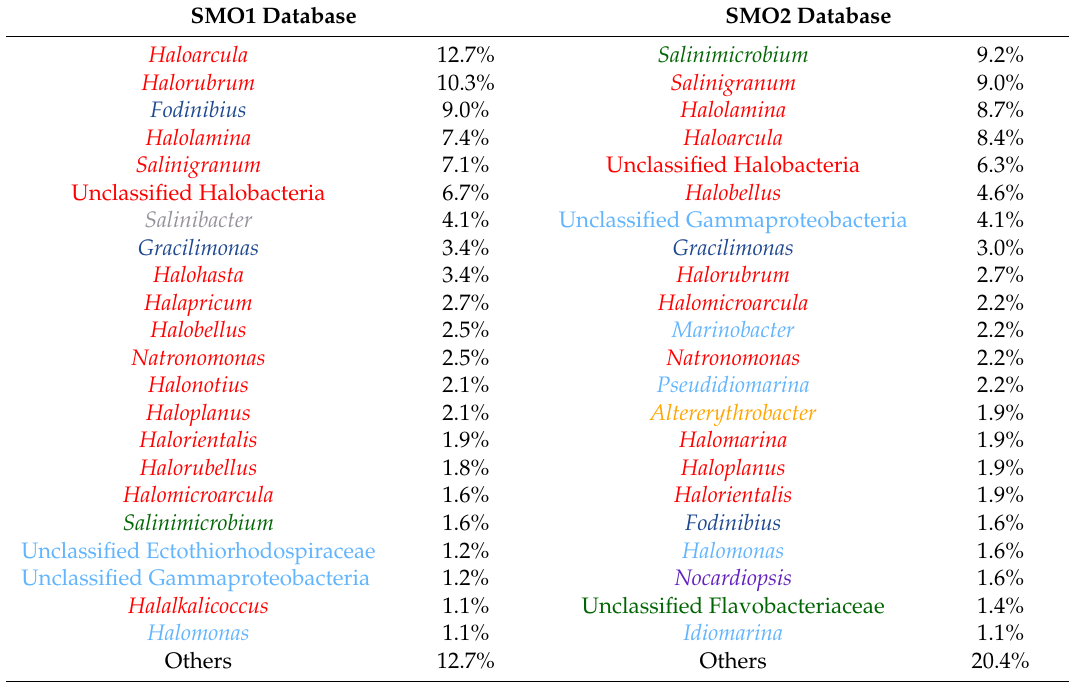
Table 2. Genus-level taxonomic affiliation of 16S rRNA genes identified in the reads from the two saline soil samples, SMO1 and SMO2. Assigned sequences have an identity over 95% and a minimum length of 100 bp. The category “Others” includes taxa represented by less of 1% of the sequences. They are colored by taxonomic group as follow: Euryarchaeota—red, Bacteroidetes—green, Gammaproteobacteria—light blue, Alphaproteobacteria—orange, and Actinobacteria—purple, Rhodothermaeota—gray, Balneolaeota—dark